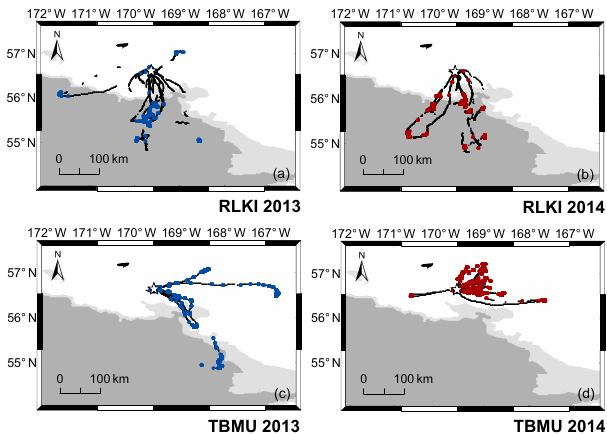
Figure 1. Foraging trip trajectories of red-legged kittiwakes, RLKI (a, b) , and thick-billed murres, TBMU (c, d) , in 2013 and 2014, respectively. Black dots represent location fixes and blue or red circles represent on-water (i.e., foraging) locations. The star indi- cates the breeding colony, St. George Island. The background shows the bathymetry: white indicates on-shelf (0–200m bottom depth), light grey is shelf break (200–1000m), and grey is oceanic basin (>1000m).